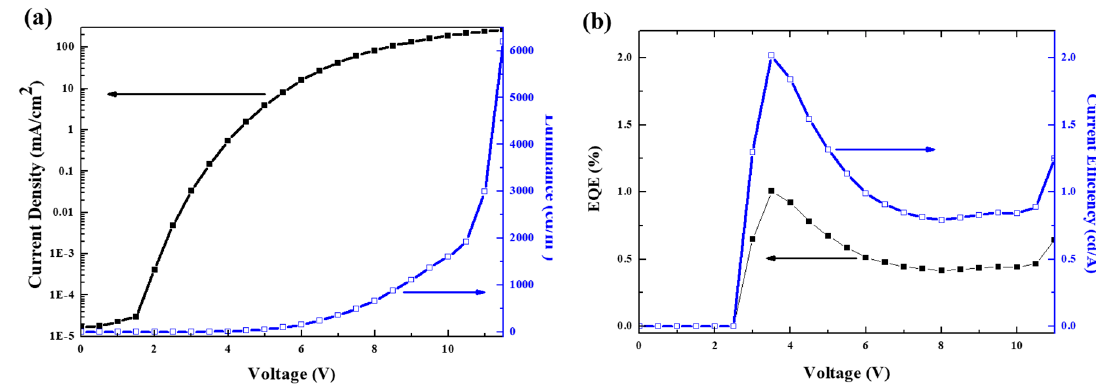
Figure 4. Characteristics in ( a ) current density–luminance with applied voltage and ( b ) external quantum efficiency (EQE)—current efficiency with applied voltage of hybrid QLEDs with double EMLs.